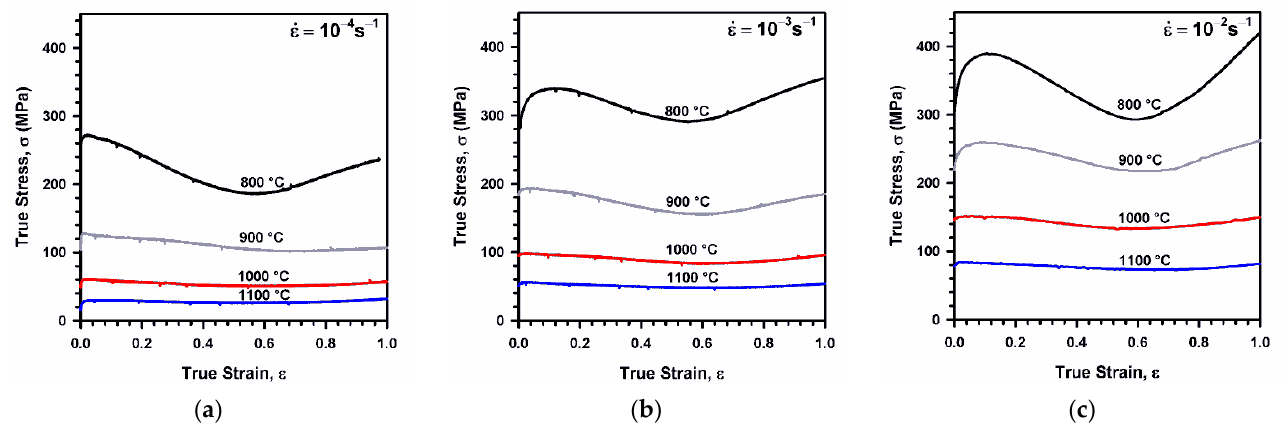
Figure 3. True stress vs. strain relationships for a highly-alloyed austenitic stainless steel subjected to isothermal compression at indicated temperatures and at strain rate of 10 − 4 s − 1 ( a ), 10 − 3 s − 1 ( b ), and 10 − 2 s − 1 ( c ).